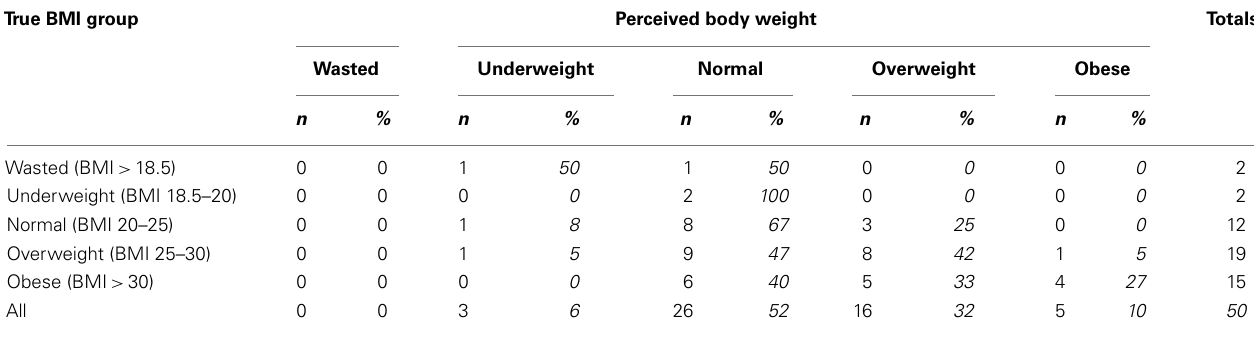
Table 4 | Descriptions used by subjects to describe body weight according to nutritional status by BMI category .